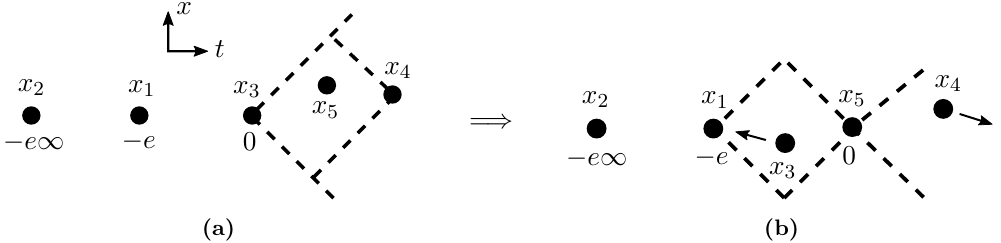
Figure 6. The “wavefunction trick” to act with a functional on a conformal block. (a) The conformal block h φ is written as an integral over an auxiliary point x , restricted to s 1 · · · φ 4 i 5 ∆ ,J a causal diamond, while x is itself integrated over the future lightcone of x . (b) The same 4 3 integral after a conformal transformation that brings x to the origin. In the heavy block limit, 5 ∆ − J ∼ ∆ 1 the integration points x and x repel each other as indicated by the arrows, gap (cid:29) 3 4 and the integral reduces to a Laplace transform of the functional (see eq.